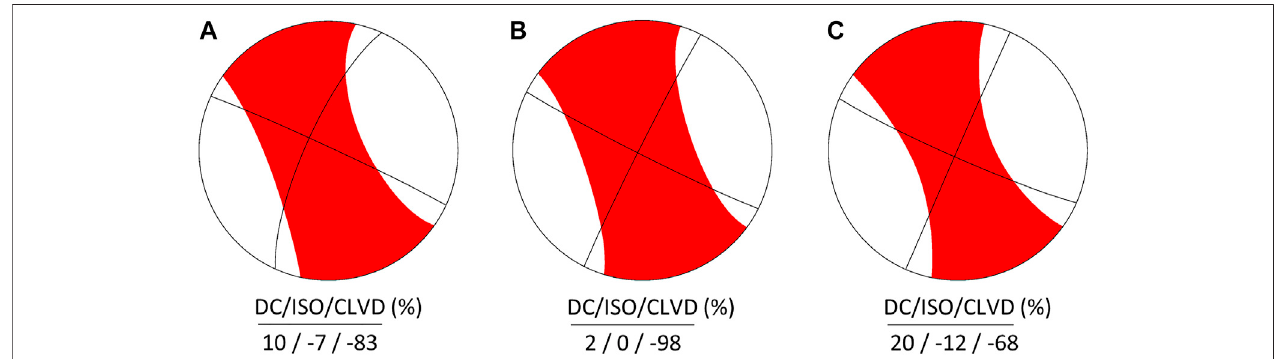
FIGURE 9| The beachballs alongwiththe faultplane solutions and the percentages ofDC, ISO and CLVD components at the bottom ofeach panel (A) This study (B) Global GMT (C) Liu and Zahradník (2020).